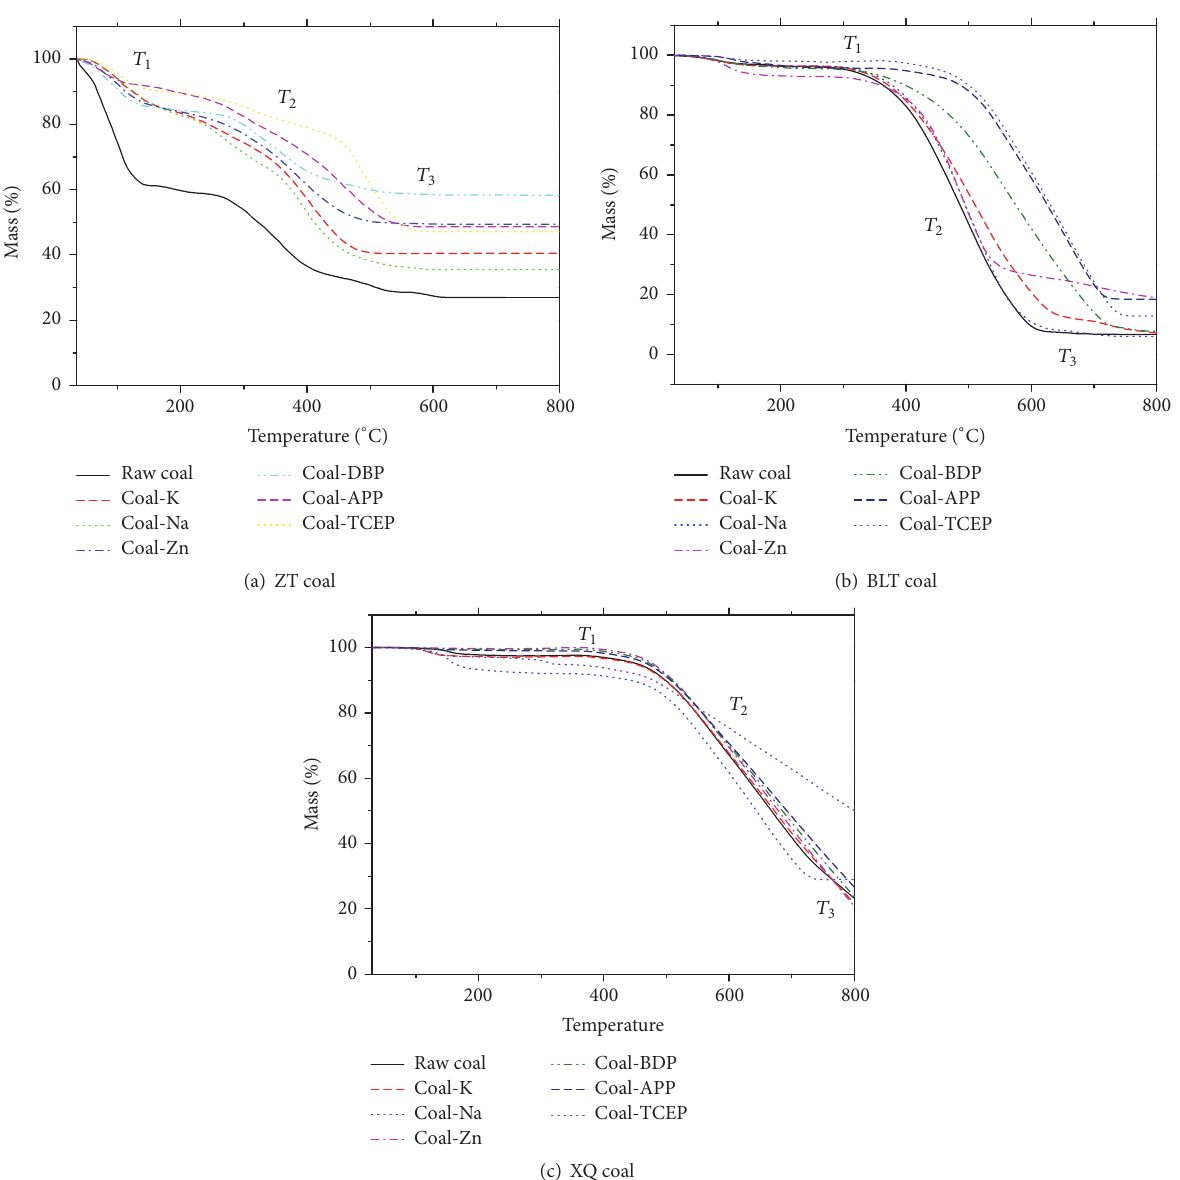
Figure 3: The TG curves of coal samples before and after